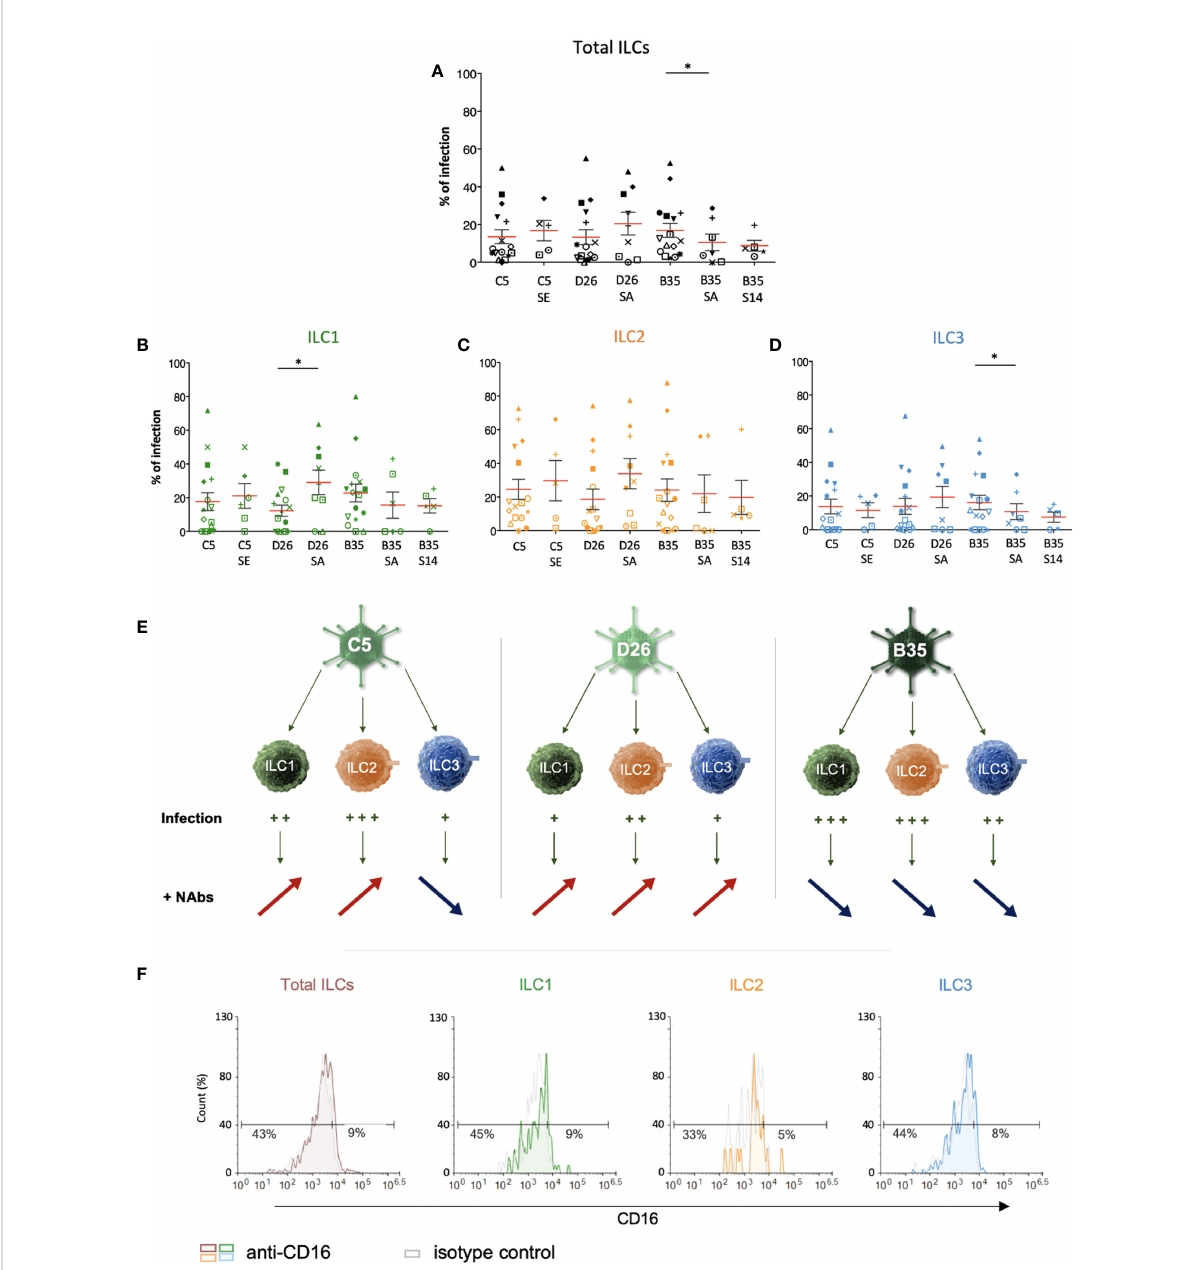
FIGURE 5 ILC uptake of HAdV-NAb complexes and impact on Fc g RIII levels. GFP levels in total ILCs, ILC1, ILC2 and ILC3 24 h post-incubation with each HAdV ± NAbs. Sera “ E ” , “ A ” , and “ 14 ” inhibit HAdV-C5, -D26, or -B35, respectively, uptake by epithelial cells. (A) Mean percentages ± SEM of total ILCs expressing GFP after HAdV ± NAbs challenge. (B-D) Mean percentages ± SEM of ILC1, ILC2, and ILC3 expressing GFP after challenge ± NAbs. (E) Summary of the impact of NAbs on ILC uptake of HAdV-C5, -D26 and -B35. (F) Levels of Fc g RIII in freshly isolated total ILCs, ILC1, ILC2, and ILC3. Statistical analyses were performed using paired Student ’ s t test by comparing uninfected cells and cells challenged with the HAdVs (ns = p > 0.05), * p ≤ 0.05 (n ≥